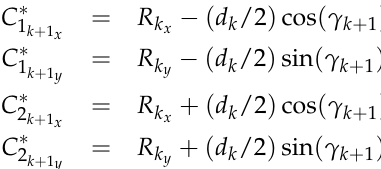
and C 2 are computed k + 1 k + 1